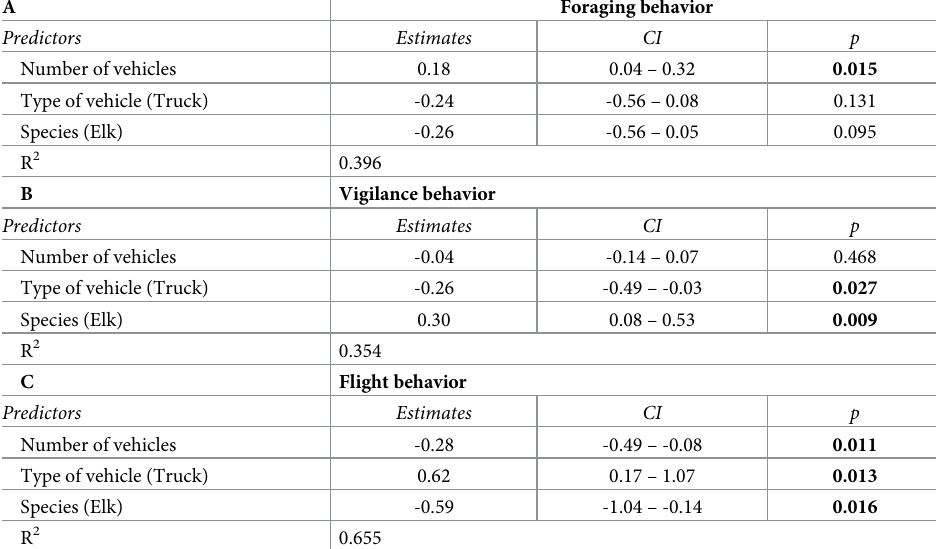
Table 1. Model results from deer and elk behavioral response to passing vehicles. Results from linear models exam- ining if passing vehicles induced a change in the proportion of time deer and elk allocated to: A) foraging; B) vigilance (standing and looking); and C) flight at wildlife underpass on the Trans-Canada Highway, Banff National Park,